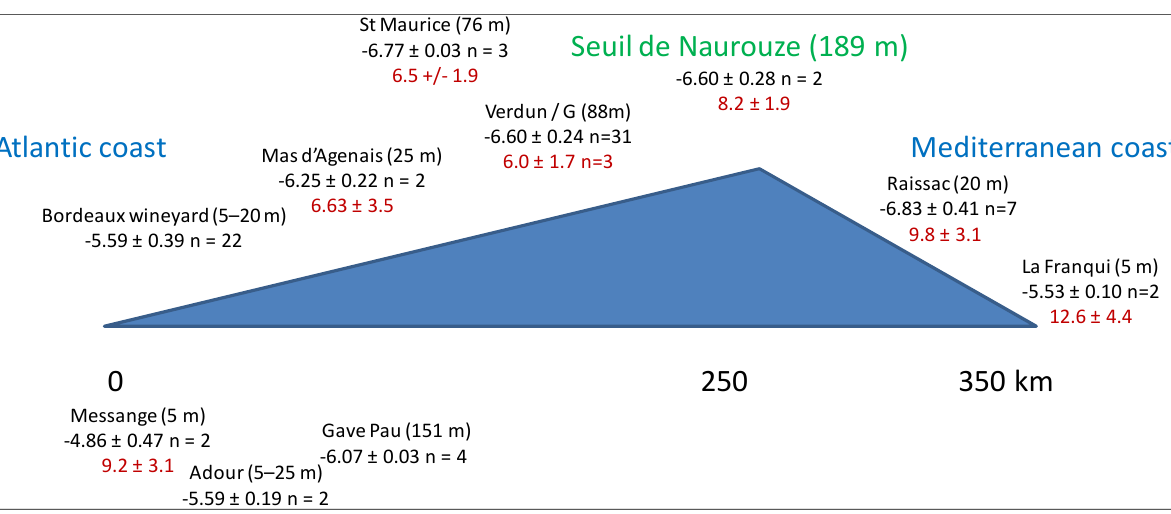
Figure 5. Continental gradient from the west Atlantic coast to east Mediterranean coast: mean isotopic values ( δ 18 O, d-excess) for the different alluvial ground water stations along the Garonne, Adour and Aude Valleys. The altitude of the station is given between